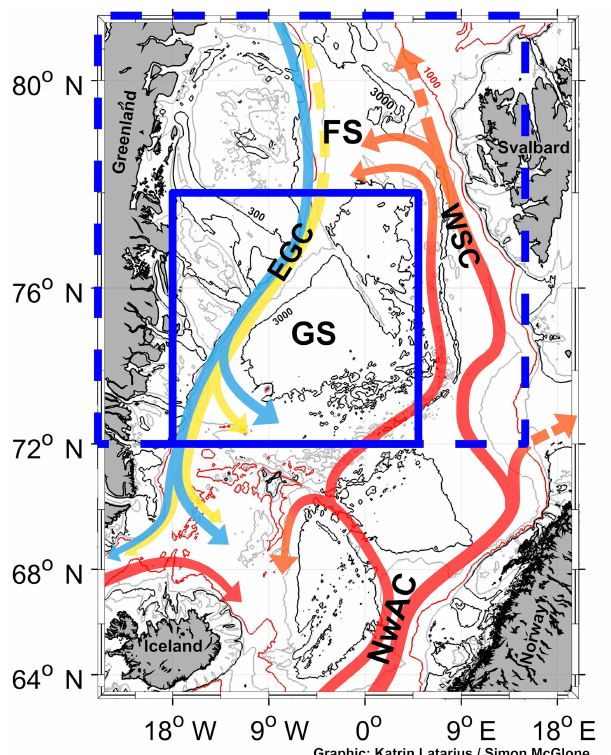
Figure 1. The map shows the Nordic Seas. Topographic contours are given on the basis of RTOPO2 (Schaffer et al., 2016): the 1000m contour is marked in red, the 3000 and 300m contours in black, and the 2000, 500 and 200m contours in gray. The inlet marked by the full blue line shows the area of Fig. 2; the inlet marked by the dashed blue line shows the area of Fig. 3. Red to yellow arrows indicate the cooling of the warm and saline Atlantic Water as it flows through the Nordic Seas and Arctic Ocean. The blue arrows indicate the flow of cold and fresh Polar Water through the Nordic Seas. EGC – East Greenland Current; WSC – West Spitsbergen Current; NwAC – Norwegian Atlantic Current; FS – Fram Strait; GS – Greenland Sea; NT – Norske